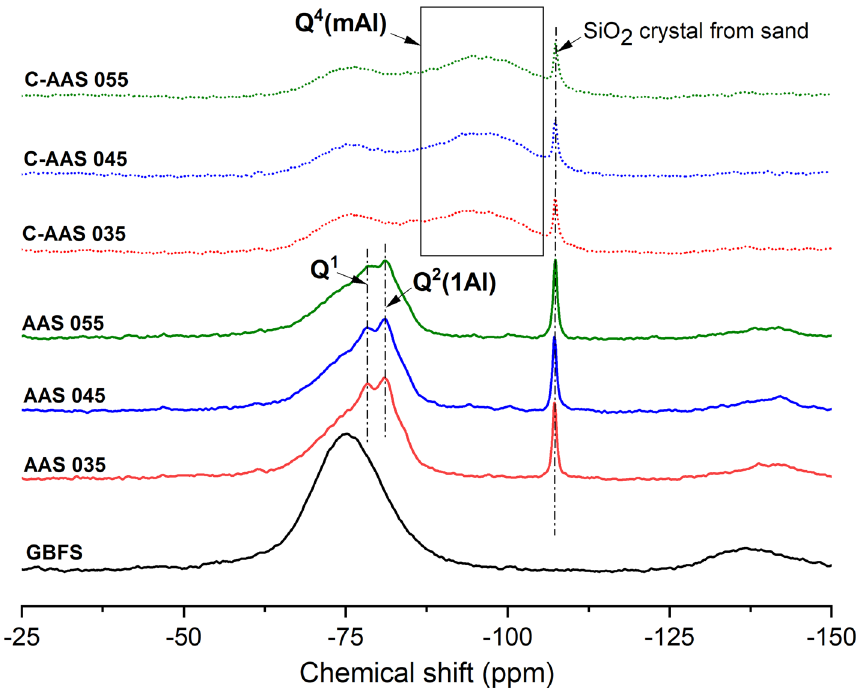
Figure 7. 29 Si MAS NMR spectra of anhydrous slag (BFS), uncarbonated alkali activated slags at 28 days of curing (AAS), and carbonated alkali activated slag after 28 days of carbonation with 1% CO 2 and 60% RH (C-AAS) at different water to binder